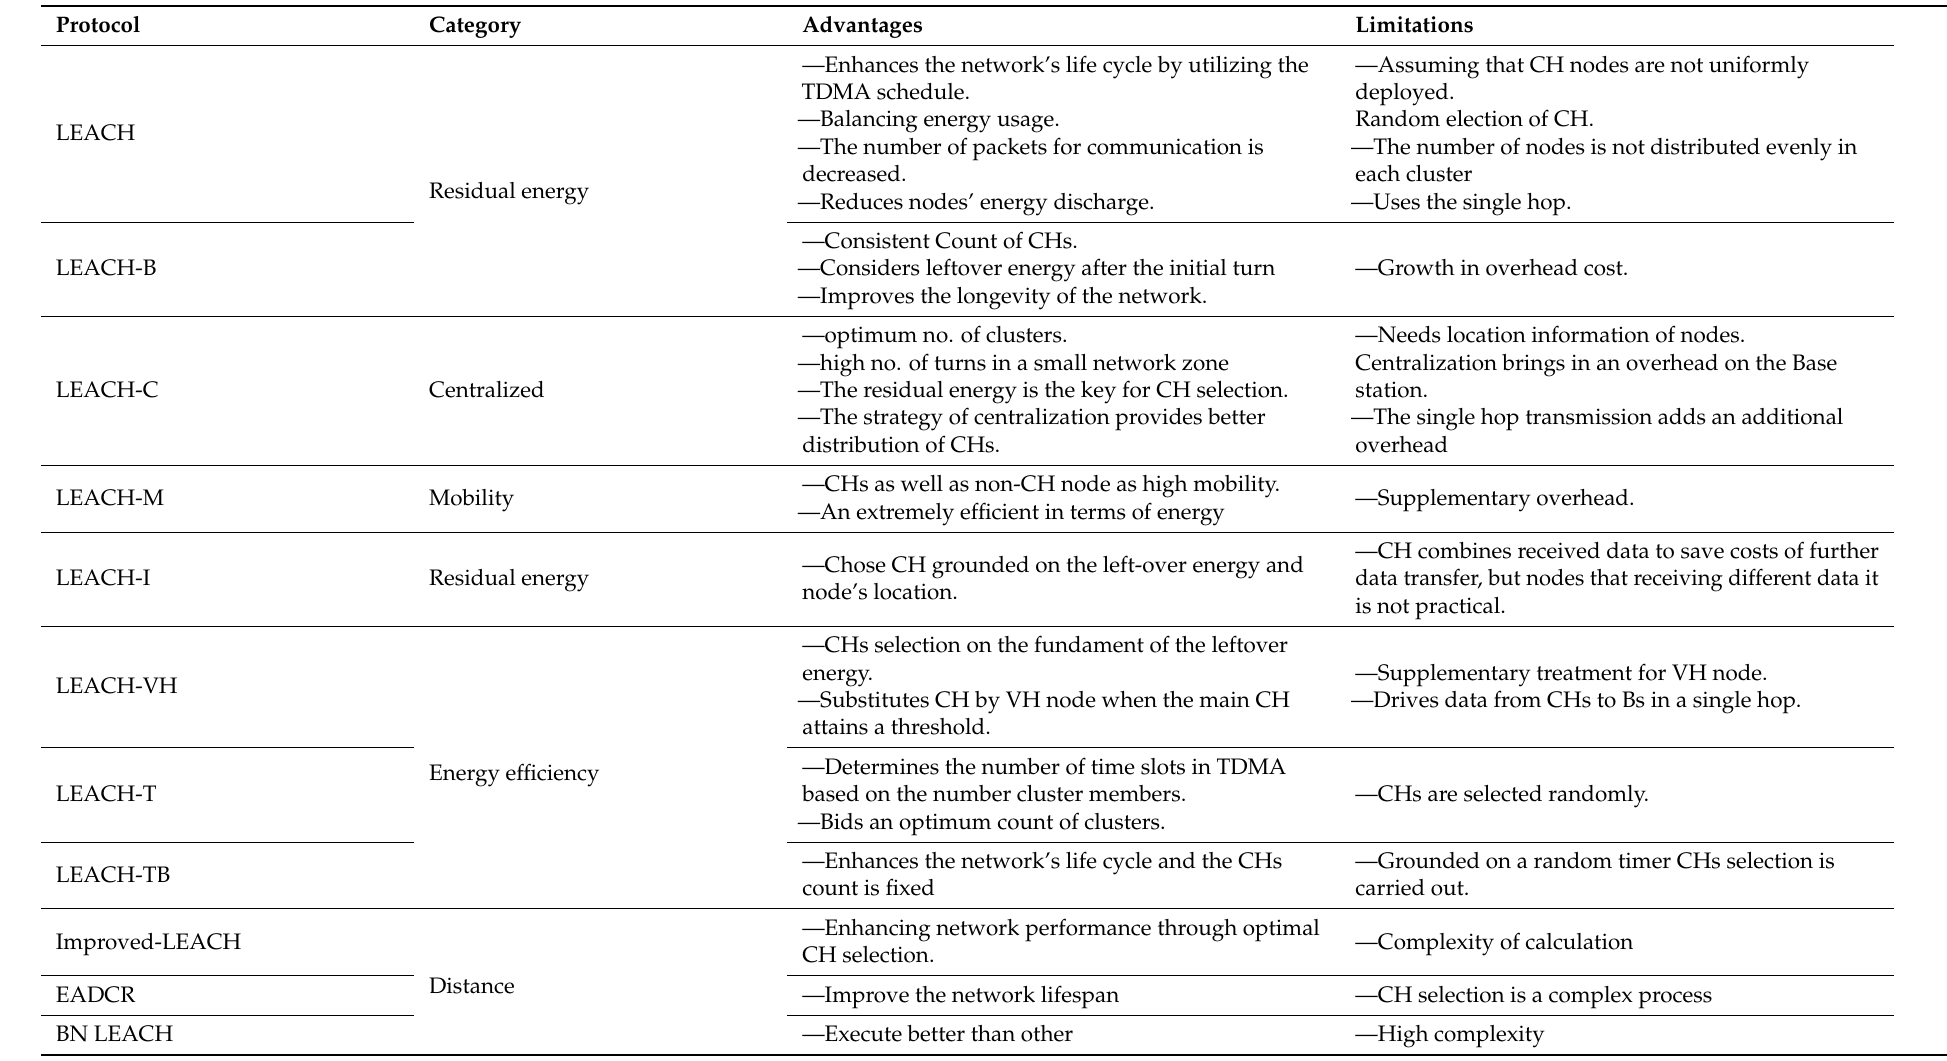
Table 2. Advantages and weaknesses of various LEACH